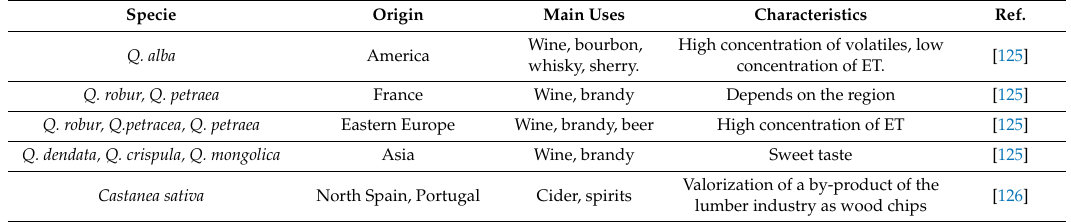
Table 2. Species used for the maturation of other alcoholic